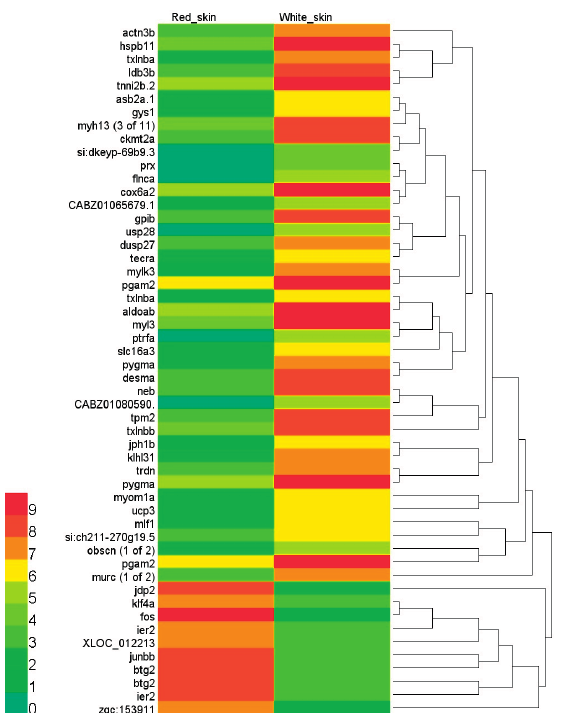
Figure 4. The expression heatmap of DEGs. The heatmap was drawn on log2 FPKM values of DEGs. The FPKM values smaller than 1 corresponded to the scale value of 0 and dark green. With the increasing FPKM values, the color progressed through yellow to red. The FPKM values greater than 512 (scale value of 9) were shown as red.